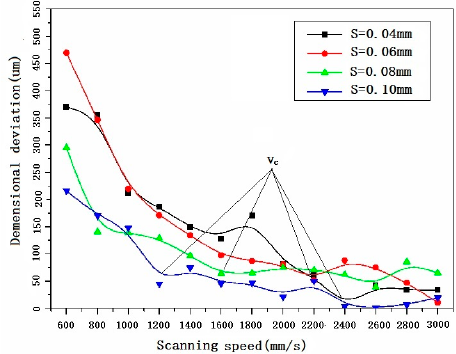
Figure 16. The dimensional deviation of SLMed struts vs. process parameters.